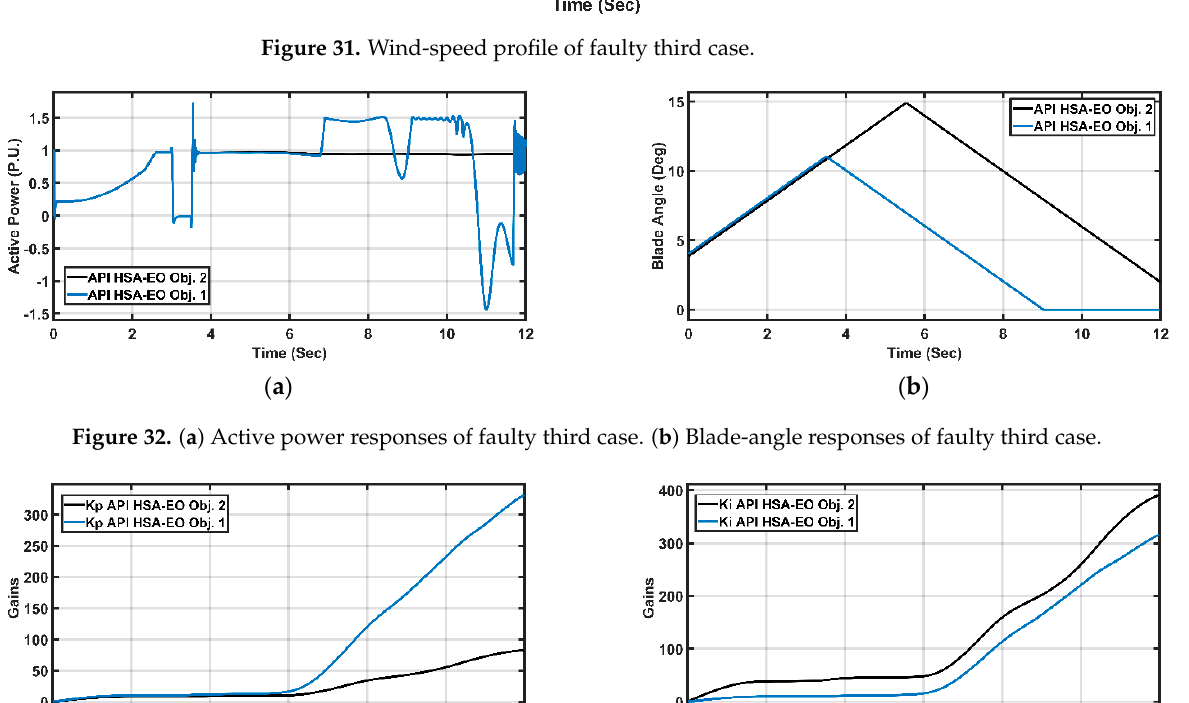
Energies 2021 , 14 , x FOR PEER REVIEW Figure 31. Wind-speed profile of faulty third case. Figure 31. Wind-speed profile of faulty third case.